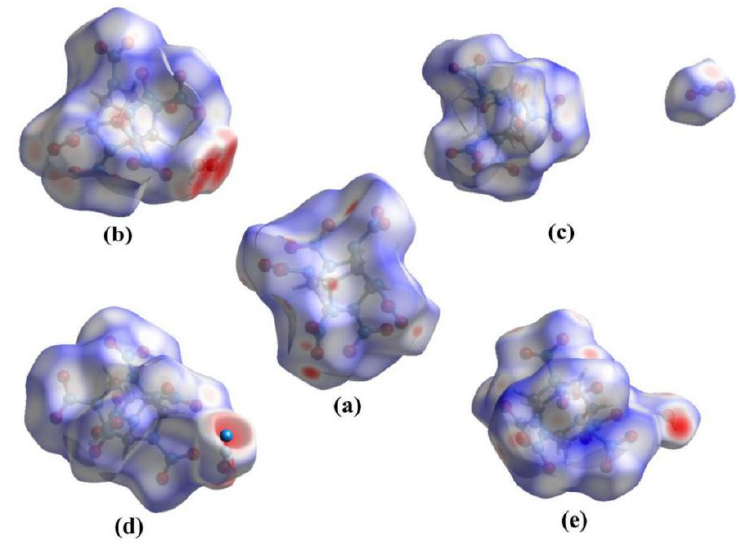
Figure 4. Hirshfeld surfaces of the CL-20 molecule and its four host–guest complexes showing inter- molecular contacts: ( a ) CL-20, ( b ) CL-20/H 2 O 2 , ( c ) CL-20/CO 2 , ( d ) CL-20/N 2 O, and ( e ) CL-20/H 2 O.